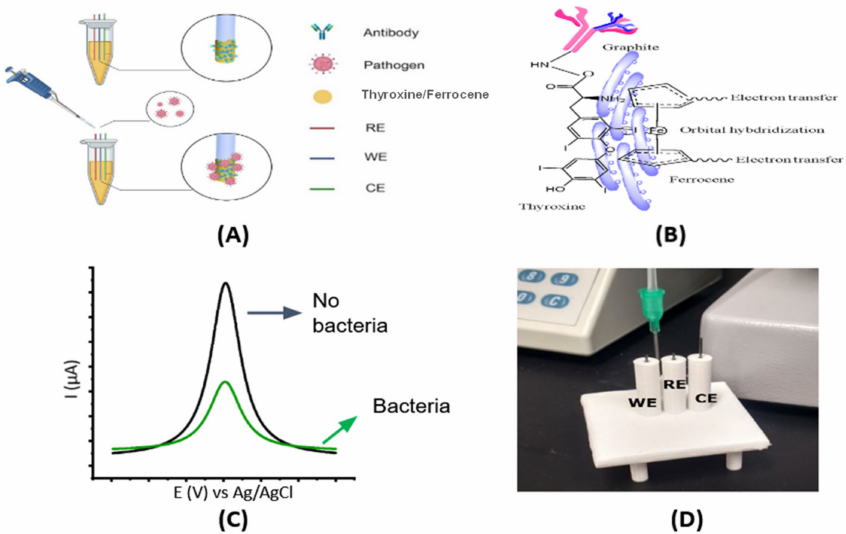
Figure 1. Overview of the system. ( A ) Scheme of developing an electrochemical biosensor for whole-cell detection. ( B ) Thyroxine/Ferrocene functionalization on pencil graphite electrodes and antibody conjugation through ECD and NHS activation. ( C ) The concept of electrochemical response of the sensor in the presence of E. coli is based on the current drop due to the specific binding of DH5 α to antibody-coated onto electrodes. The E. coli cells bound onto the electrode prevent electron transfers from the redox probe ([Fe(CN)6] 3 − /4 − ) to the working electrodes. ( D ) An electrochemical cell containing a three-electrode configuration was made from a 3D-printing